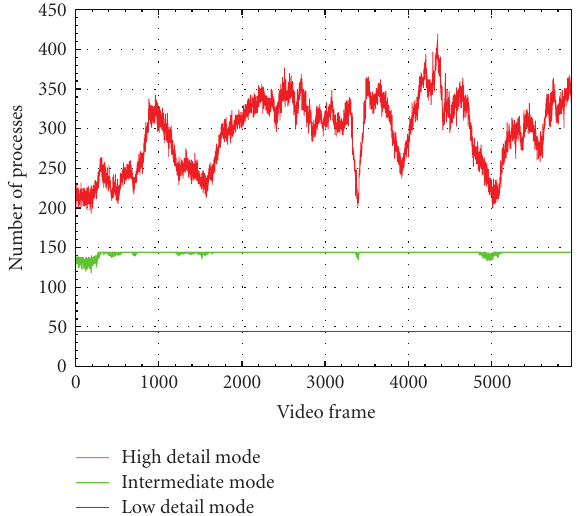
Figure 14: Number of processes created and managed by the OS model during the application simulation on a set of 6000 images for each